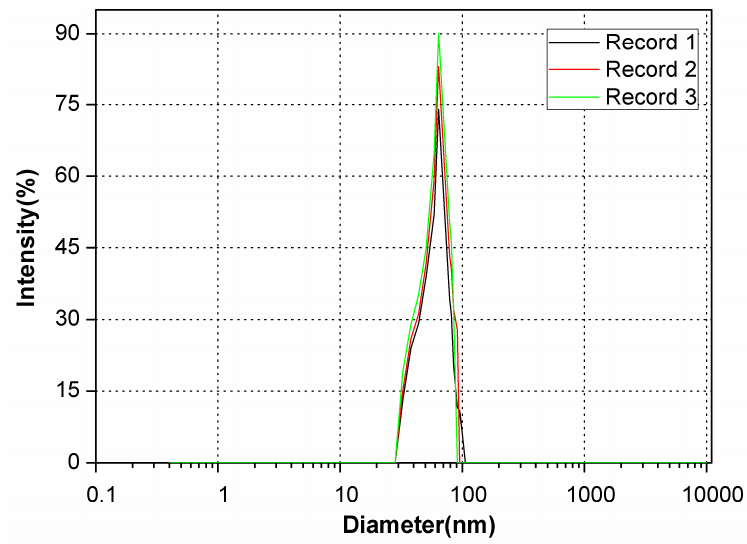
Figure 3. Dynamic light scattering (DLS) particle size distribution of SDS/FeSP nanocomposite. The measurements were performed of the samples after 1 h of ultrasoncation at 25 °C.